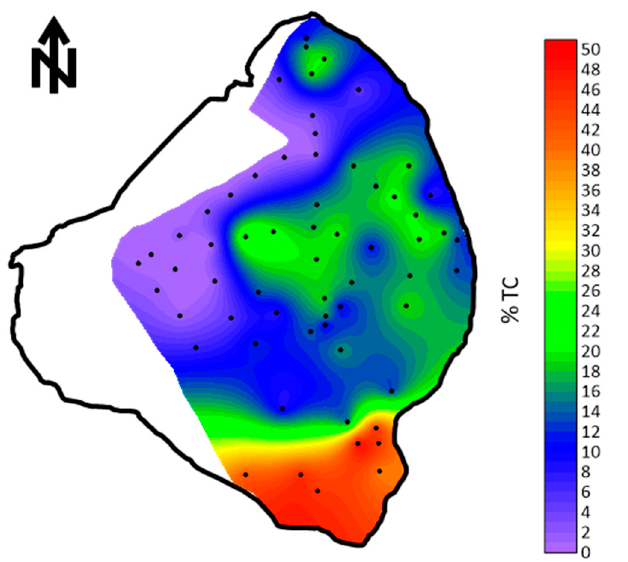
Figure 6. Total carbon percent (organic and inorganic) in the bottom sediments of Lake Okeechobee [4].